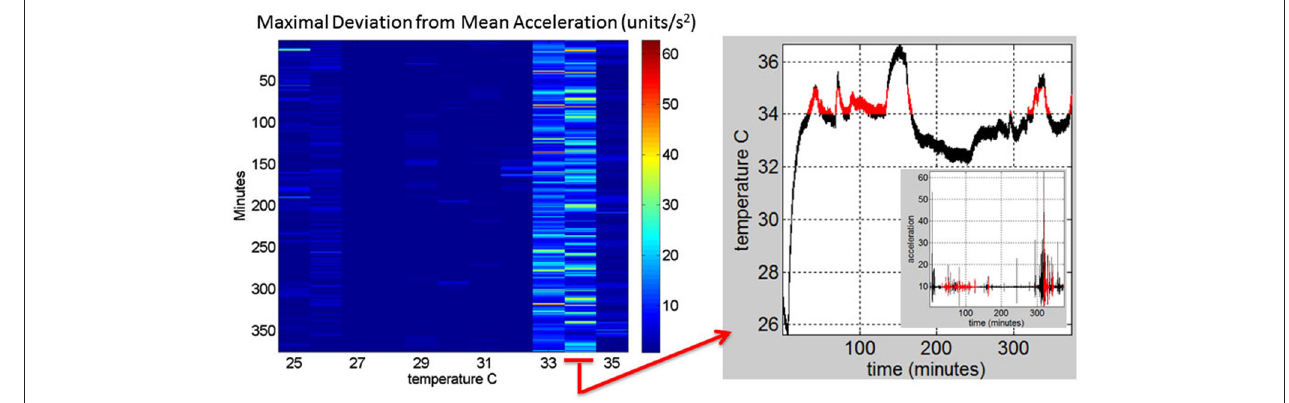
acceleration at each ◦ C-interval (columns) and for each minute (rows) of the session. The right panel shows the 34--35 ◦ C-interval (red) and the inset shows the linear acceleration data corresponding to that temperature ◦ C interval. On the left panel the 34--35 ◦ C-interval is marked to show the patterns of the maximal deviation from the mean acceleration over the session’s time length.